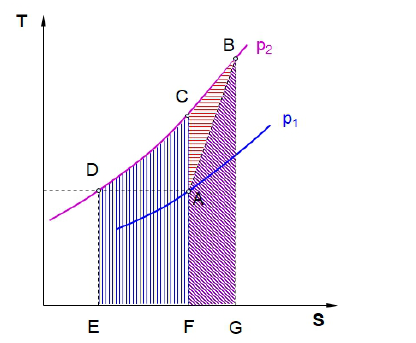
Figure 1. Isentropic (area ACDEFA ) and actual work (area GBCDEFG ) in T-S diagram when compressed from pressure p 1 to pressure p 2